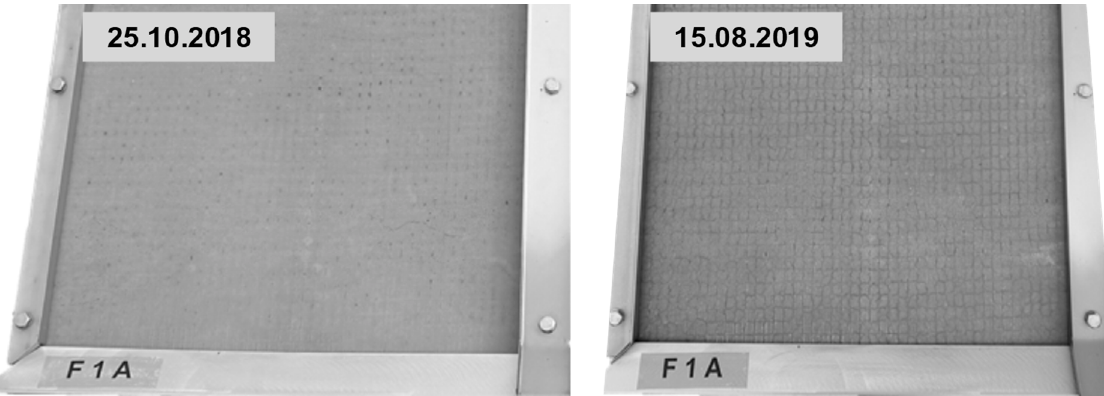
Figure 17. Surface of outdoor test specimen F1A after two and 44 weeks of exposure.